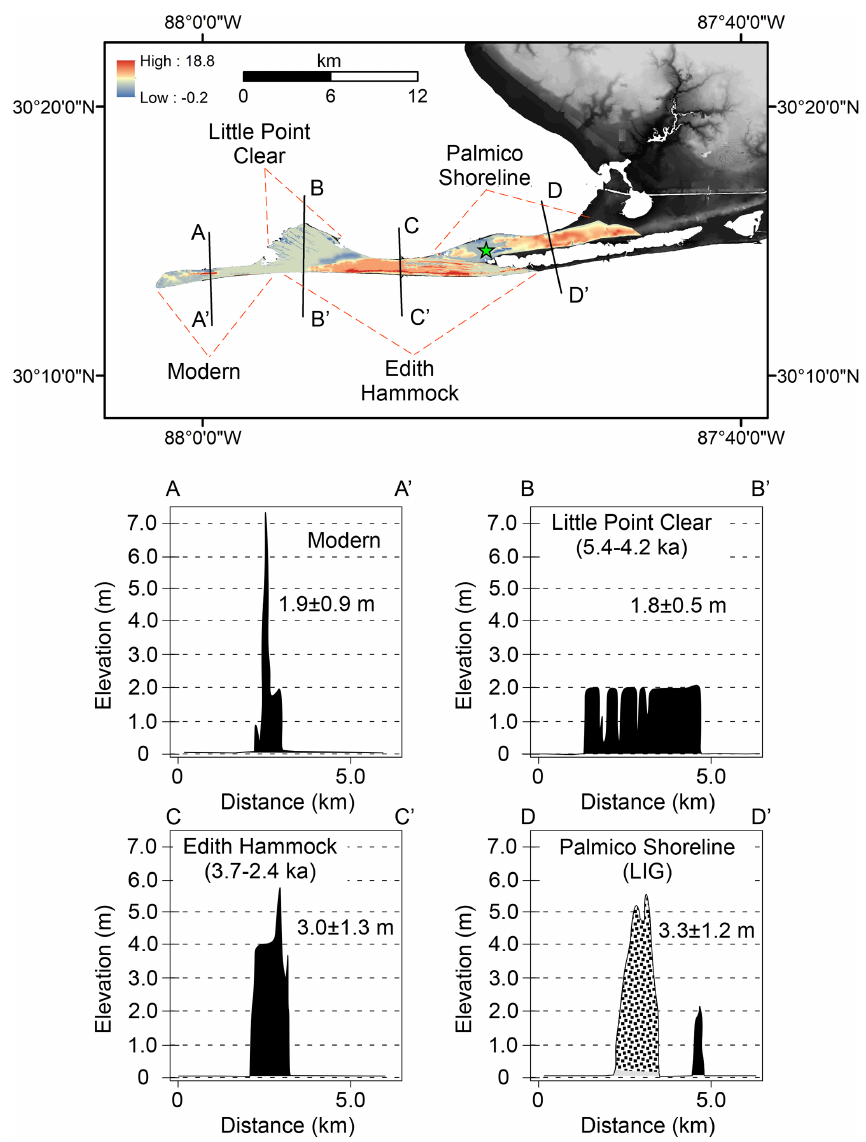
Figure 7. Digital elevation model and topographic profiles through the three Holocene (A–A (cid:48) , B–B (cid:48) , and C–C (cid:48) ) and the Pamlico (LIG, D–D (cid:48) ) shorelines at Fort Morgan Peninsula, Alabama. See Fig. 4 for profile symbol